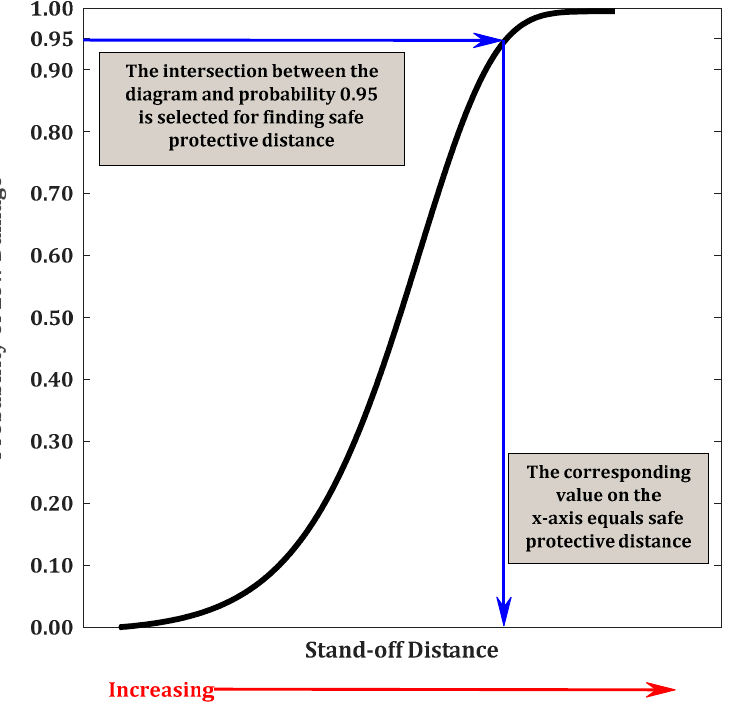
Figure 3. The concept of calculating SPD.